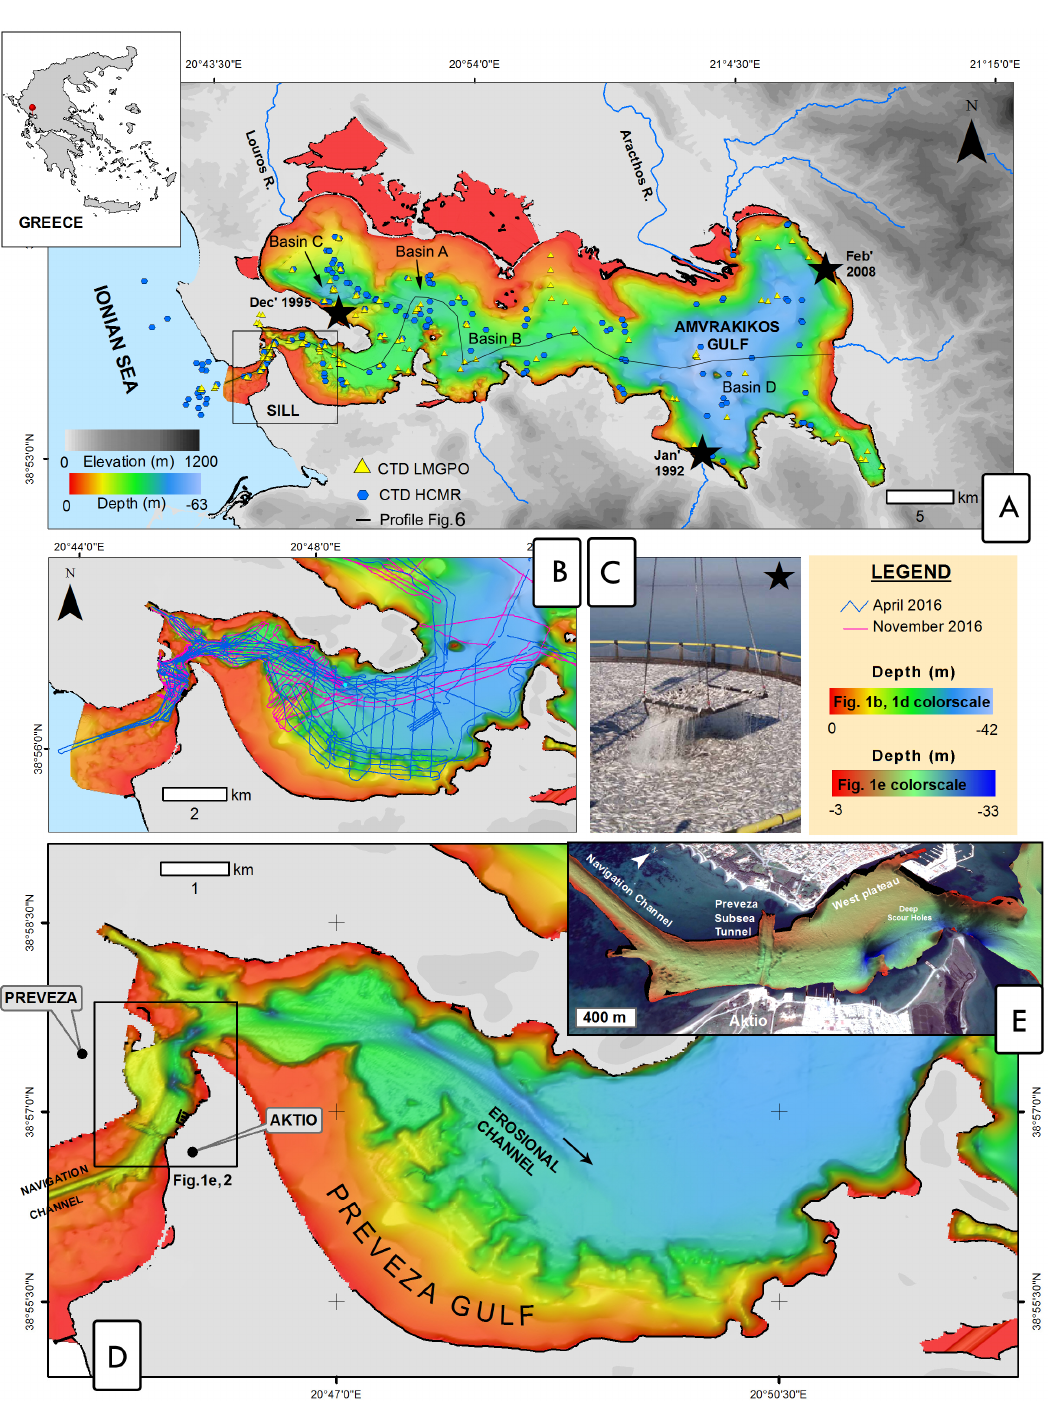
Figure 1. ( A ) General bathymetry of Amvrakikos Gulf, locations of massive farmed-fish mortality events (black stars), and CTD stations involved in this work (yellow triangle CTD stations from the Hellenic Center for Marine Research and blue circles from the Laboratory of Marine Geology & Physical Oceanography), and the location of the profile of Figure 6, ( B ) Geophysical survey track lines of the current study, ( C ) fish mortality event in February 2008, ( D ) detailed bathymetry of the sill acquired during this study using MBES, indicated in Figure 1E and Figure 2 with a black rectangle, and ( E ) magnified 3D bathymetry of the Preveza Strait showing the navigation channel, subsea tunnel, dredged west plateau, and scour